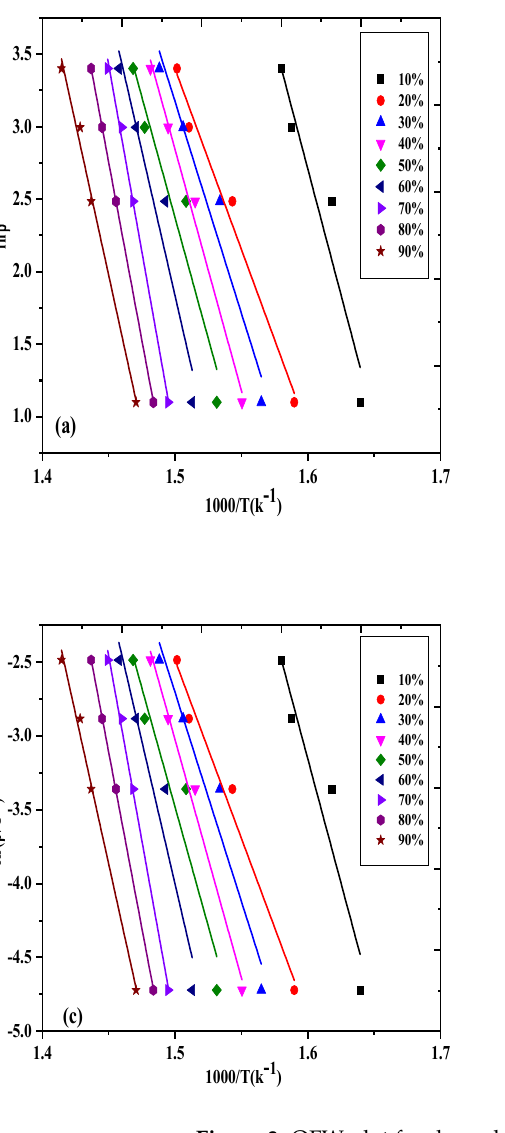
Figure 3. OFW plot for degradation of waste PP ( a ) without the catalyst and ( b ) with the catalyst at various conversions. KAS plot for degradation of waste PP ( c ) without the catalyst and ( d ) with the catalyst at various conversions.